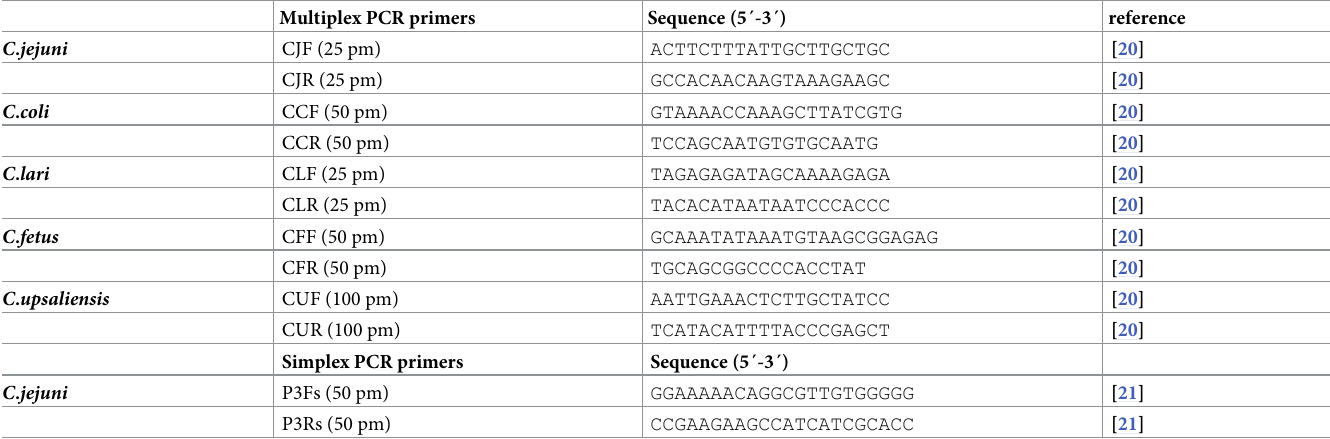
Table 1. List of primers used for